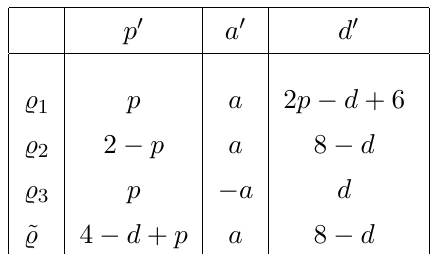
Table 1. Symmetries of the Calogero-Sutherland model for generic values of the parameters. The last symmetry also involves a shift (cid:28) 0